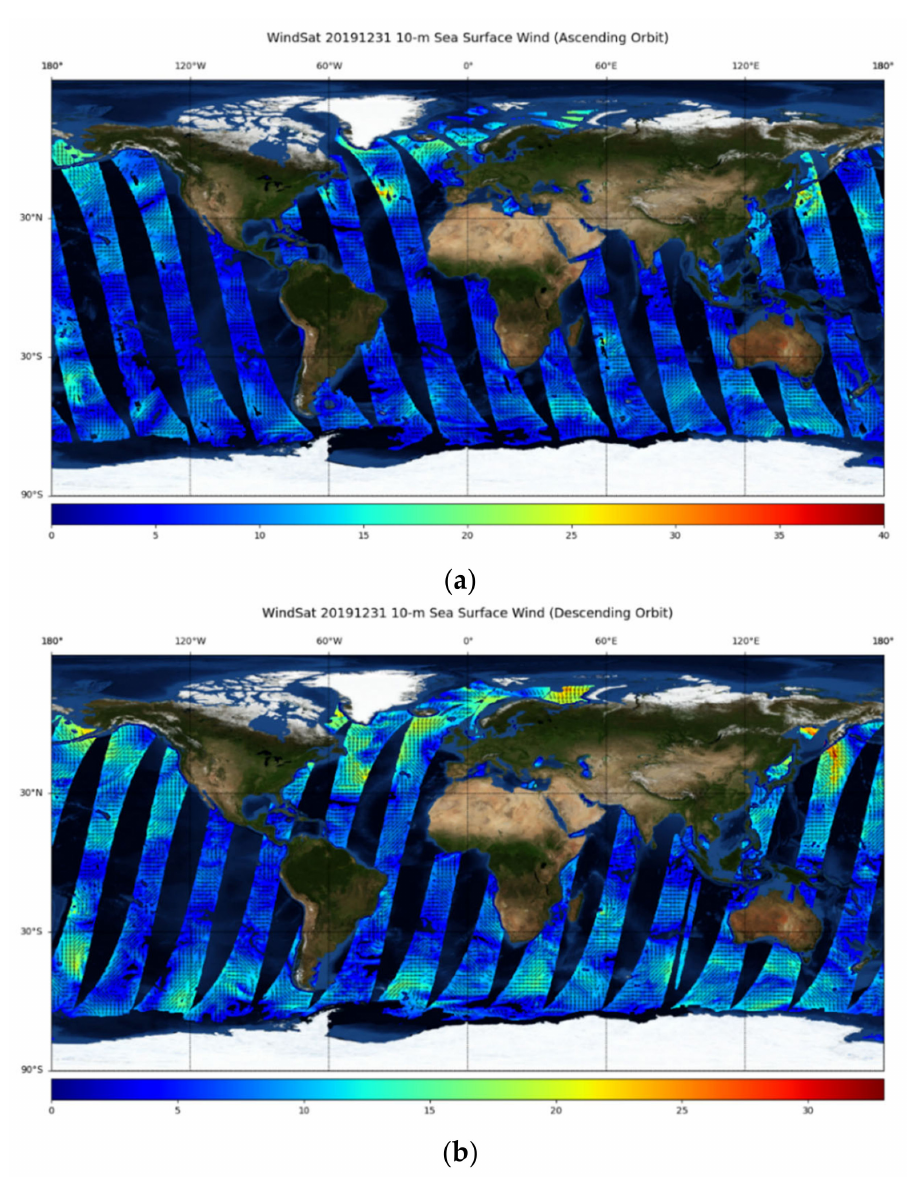
Figure 2. Global 10 m sea surface wind data of WindSat from RSS system, taking the 31 December 2019, as an example: ( a ) The ascending passes; ( b ) The descending